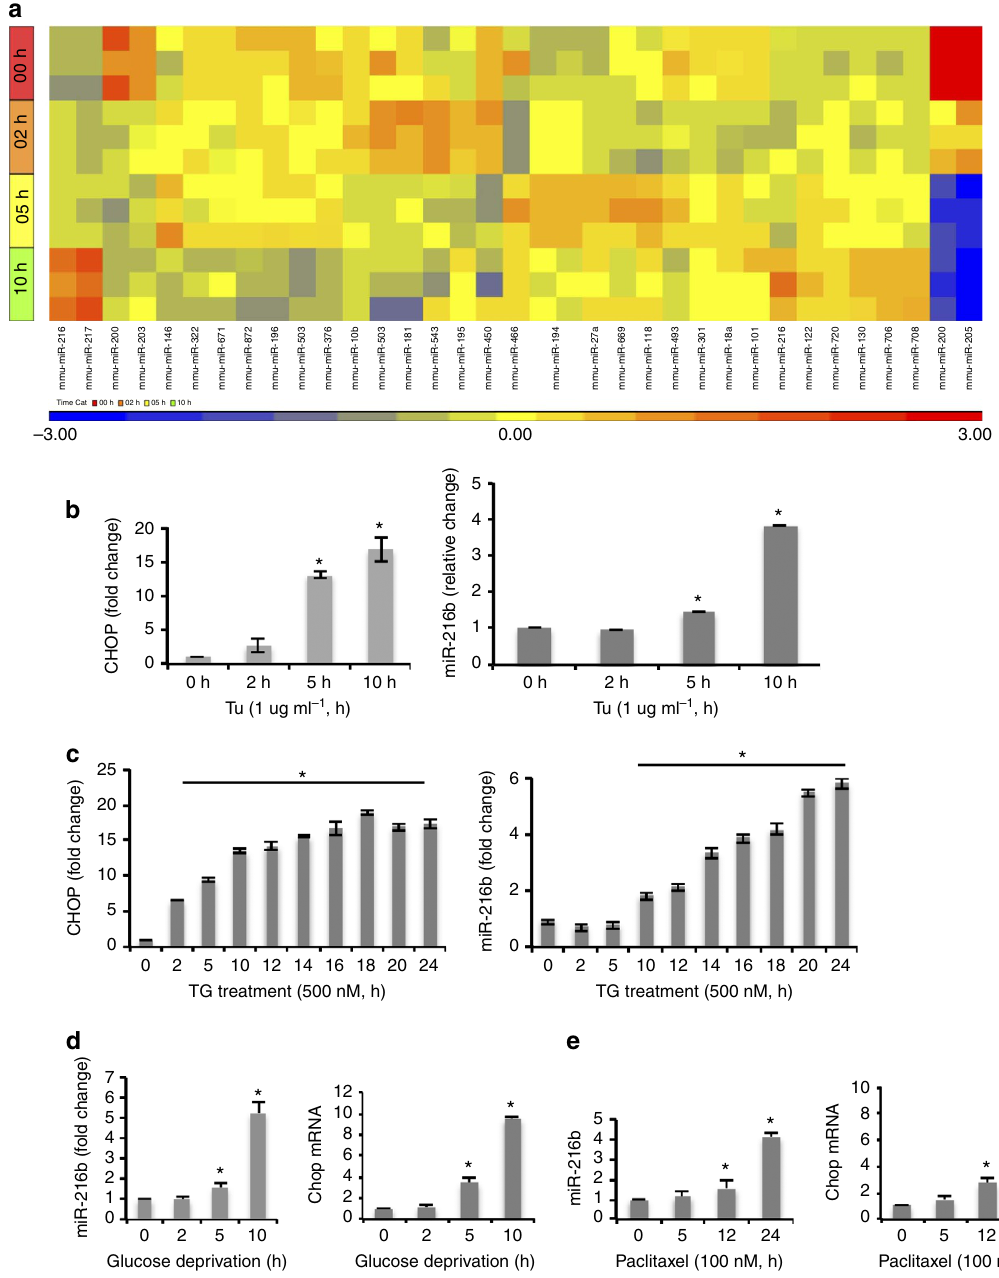
Figure 1 | ER stress induced miR-216b expression. ( a ) Heat map depicting differentially expressed microRNAs (at least two-fold) following exposure to tunicamycin (Tm) as indicated. ( b , c ) qPCR analysis of CHOP mRNA levels and miR-216b expression in NIH3T3 cells treated with Tm (1 m gml (cid:2) 1 ) or thapsigargin (TG, 500nM) for indicated times. Averages are calculated from three independent experiments. ( d ) qPCR analysis of miR-216b expression and CHOP mRNA levels in NIH3T3 cells cultured in low-glucose medium for indicated times. ( e ) qPCR analysis of miR-216b expression and CHOP mRNA levels in U2OS cells treated with paclitaxel (100nM) for indicated times. Data are mean ± s.d. of three independent experiments. Statistical analysis was analysed by Student’s t -test. (* P o 0.05, treatment versus